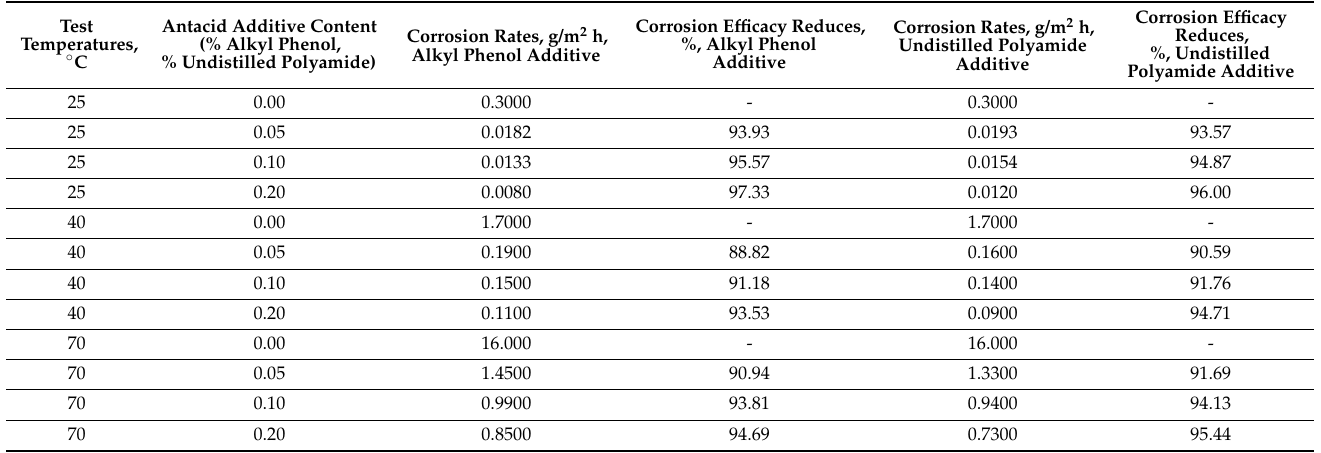
Table 5. Corrosion rate determined on samples collected from the material of the distillation column (OL37), introduced in a bath with HCl in proportion of 5%.